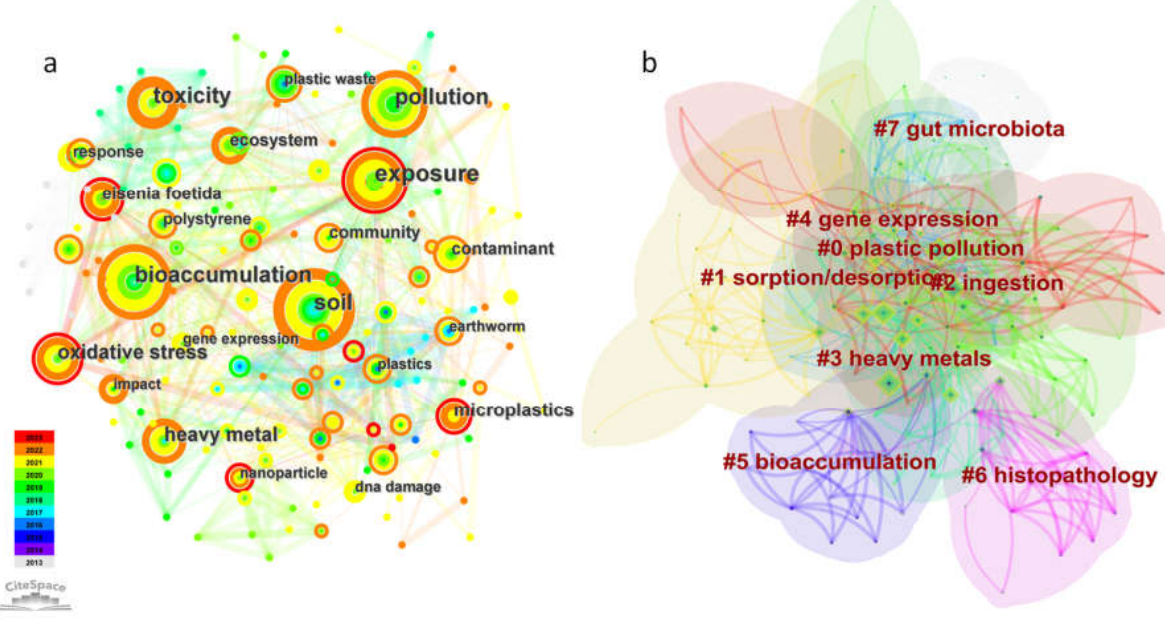
Figure 5. Co-occurrence keyword network ( a ) and co-occurrence clustering keyword network ( b ) in the field of micro(nano)plastic toxicity to earthworms. Table 3. Knowledge clusters in the field of micro(nano)plastic toxicity to earthworms based on key- word co-occurrence.